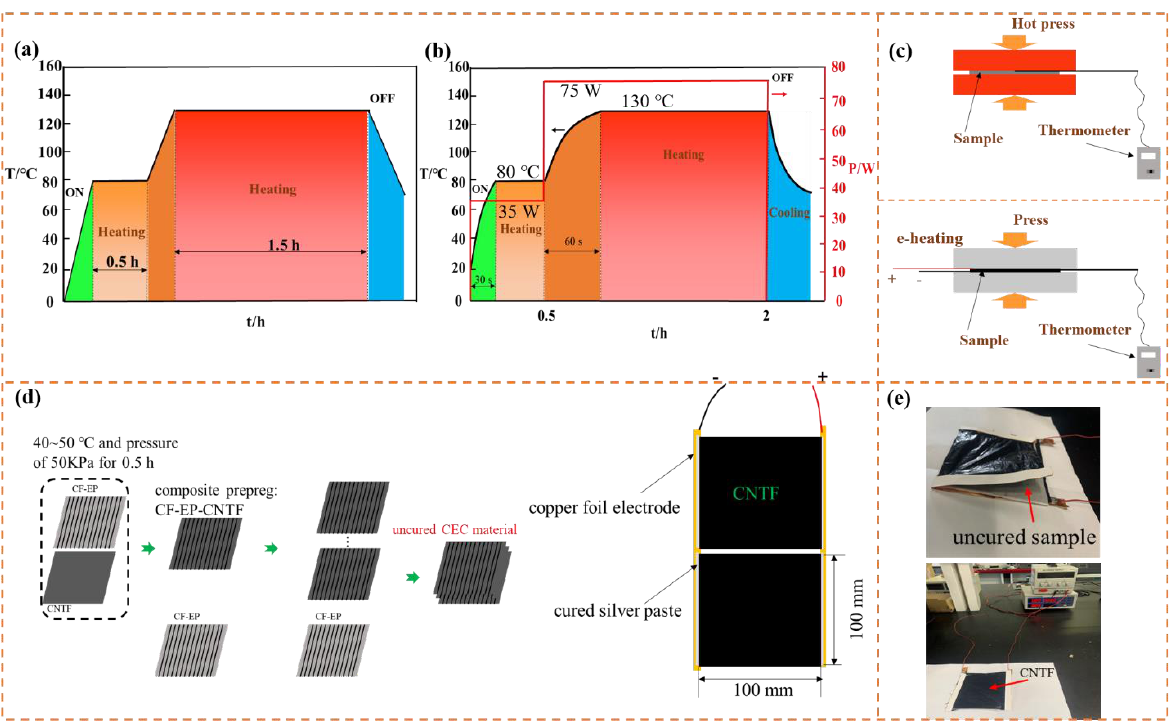
Figure 1. The curing temperature profile of samples by ( a ) oven and hot press, ( b ) e-heating; schematic diagram of ( c ) hot press (up) and e-heating (down) and ( d ) composite prepreg, sample preparation method and CNTF electric heater; ( e ) images of sample. Table 1. Presentations of sample 1~15.